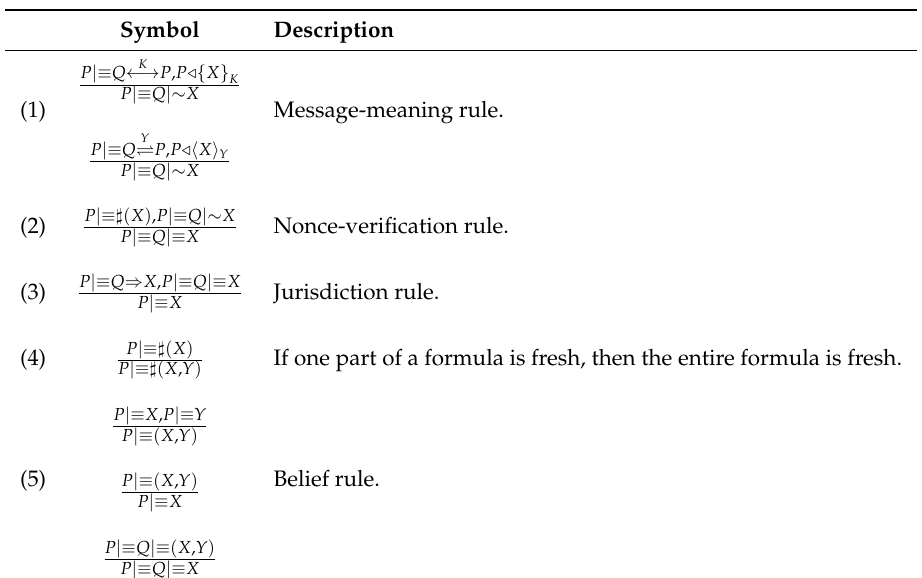
Table 3. BAN logic